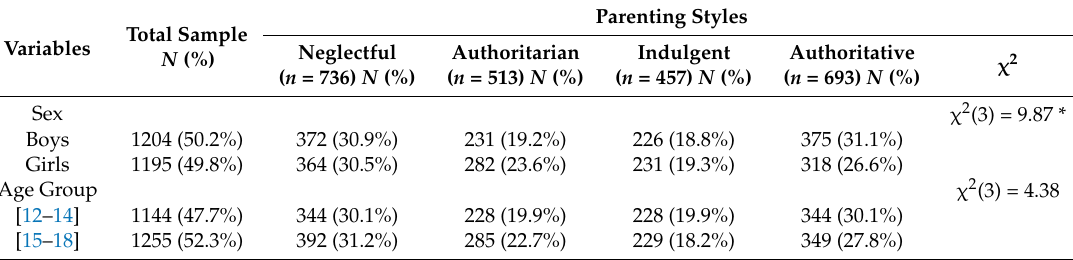
Table 1. Sociodemographic variables.